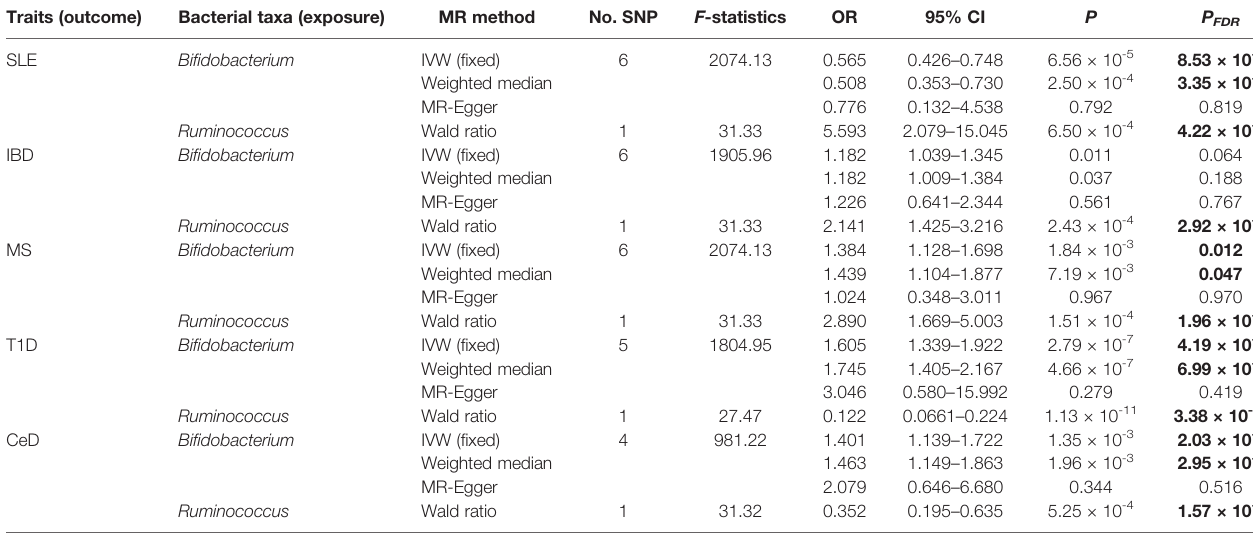
TABLE 2 | Signi fi cant MR analysis results in the discovery samples. Traits